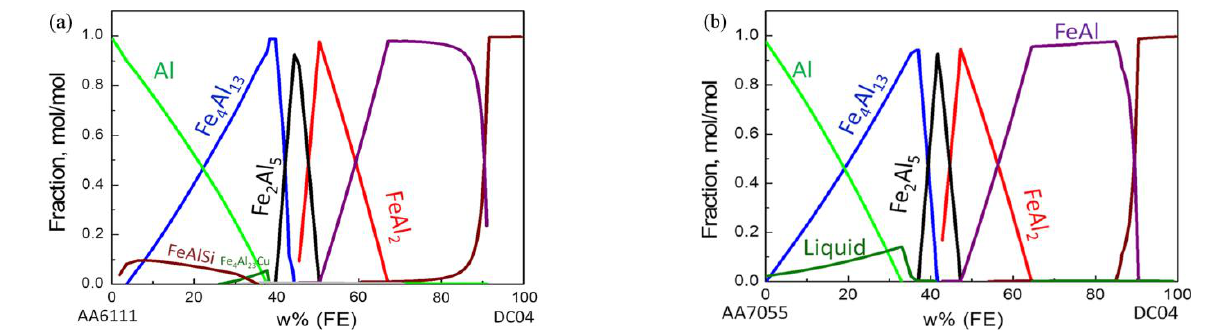
Figure 19. CALPHAD predicted equilibrium phase fractions as a function of Fe [44]: ( a ) AA6111-to- DC04-steel; ( b ) AA7055-to-DC04-steel.